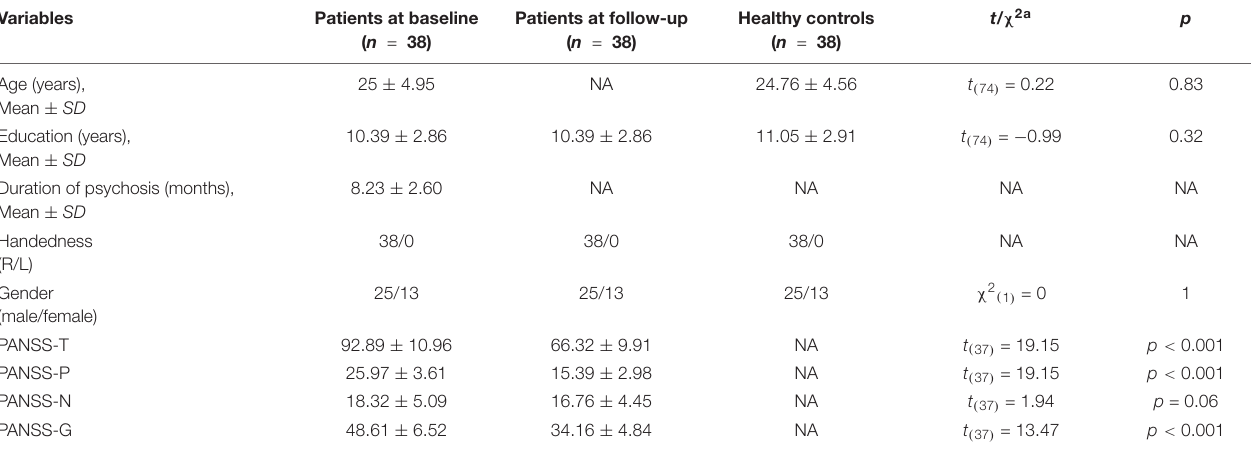
TABLE 1 | Demographics and clinical symptoms for healthy volunteers and patients both at baseline and follow-up. Variables Patients at baseline